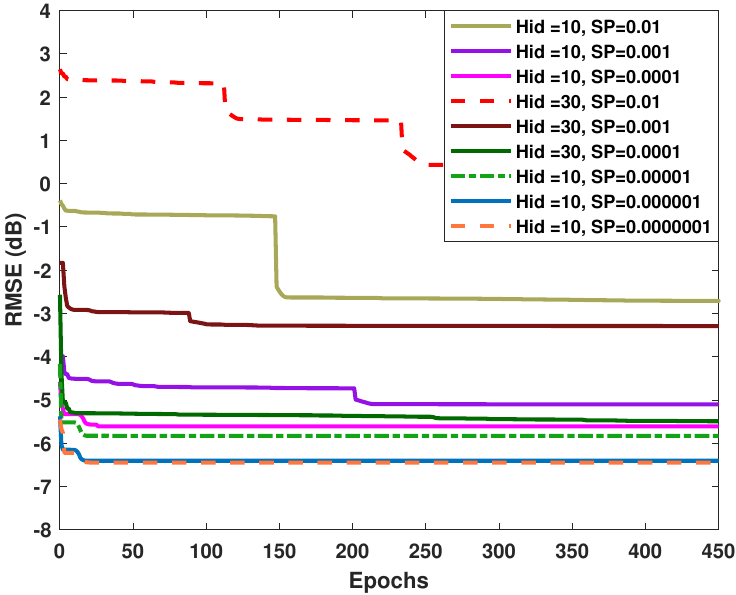
Figure 9. RMSE of the proposed network versus the number of epochs for different hidden sizes and sparsity